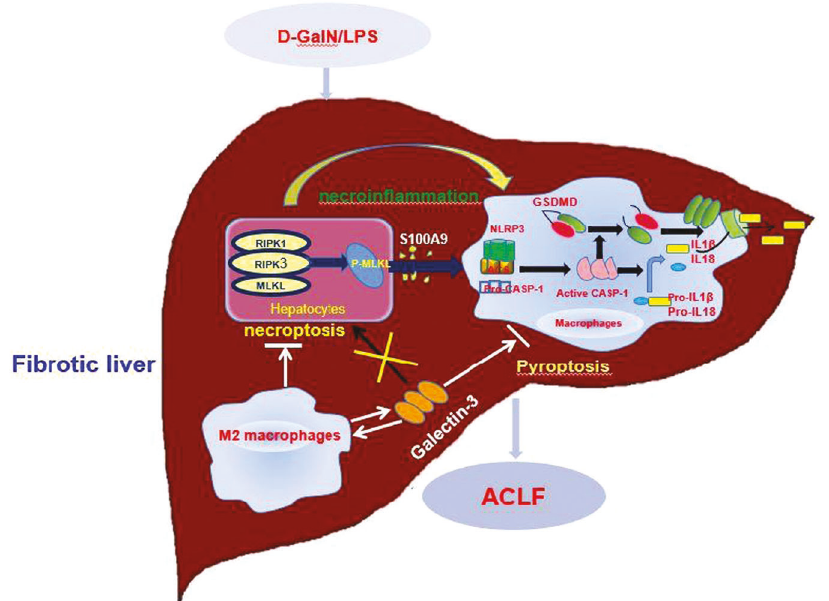
Fig. 8 An illustration of the pivotal role of GAL3 in the hepatoprotection conferred by M2-like macrophages in ACLF. GAL3 is produced by M2-like macrophages and promotes M2-like macrophage activation, then exerts the hepatoprotective effects in ACLF through inhibiting pyroptosis but not necroptosis